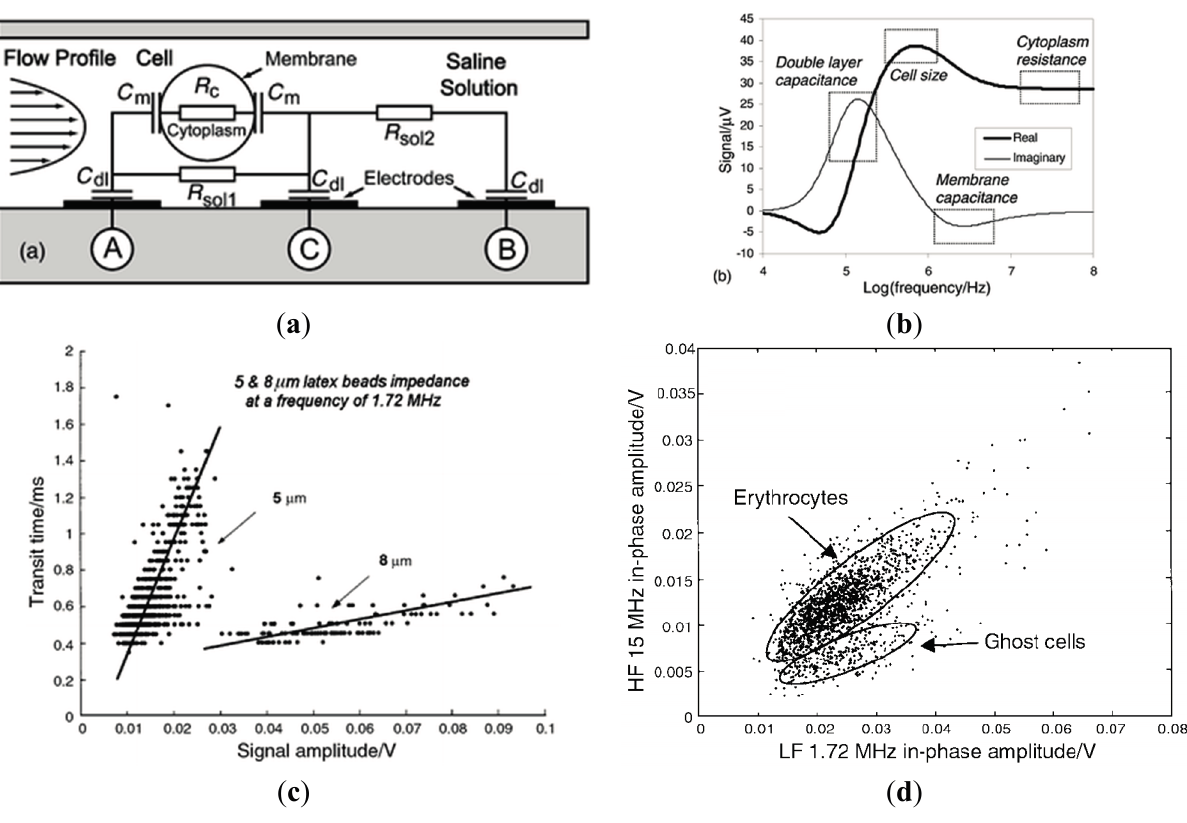
Figure 1. ( a ) The first-generation microfluidic impedance flow cytometry where a microfluidic chip with integrated channels and a differential pair of coplanar microelectrodes were proposed to quantify two-frequency impedance data of single cells flushed through the measurement area in a high-throughput manner; ( b ) The complex impedance spectrum of a cell is simulated using an equivalent circuit model where impedance data at various frequency domains indicate the electrical double layer, cellular size, membrane capacitance and cytoplasm resistance, respectively; ( c ) Impedance amplitude difference of 5 and 8 μ m latex beads, confirming that impedance data at ~1 MHz can reflect particle sizes. Note that “transit time” indicates the traveling velocity of latex beads which were also obtained from impedance data; ( d ) Normal erythrocytes and erythrocyte ghost cells were characterized, with comparable low-frequency impedance data indicating size comparability and significant differences at high-frequency impedance data suggesting cytoplasm conductivity differences